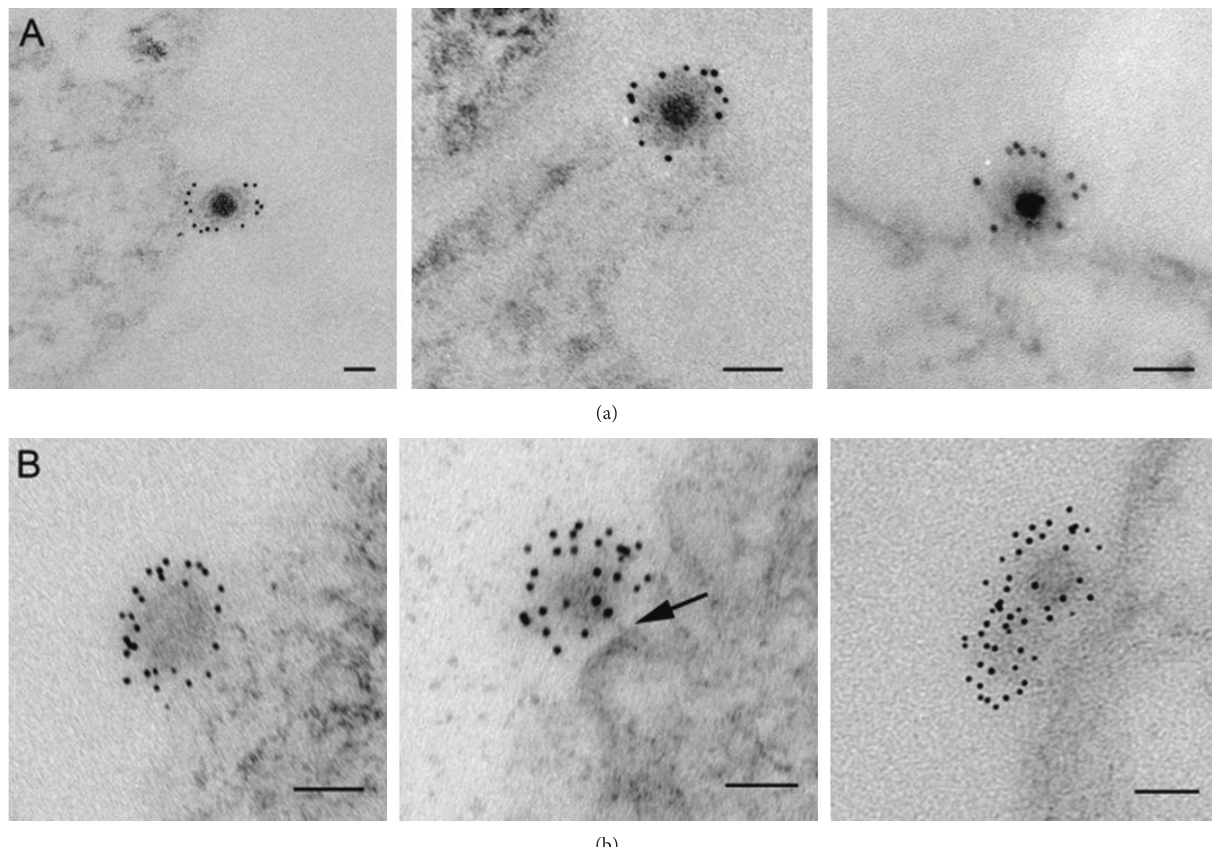
Figure 13: Thin-section electron microscopy of Sindbis virus-cell complexes at pH 7.2. A panel of images obtained by TEM illustrates two representative populations of particles at different incubation temperatures. High-magnification images show examples of electron-dense full particles at the cell surface at 4 ∘ C (row (a)) and empty particles with loss of RNA electron density predominantly at 37 ∘ C (row (b)). In row (b), middle panel, there is indication of a stalk connecting the virus and the cell (arrow). Bars, 50 nm. From Vancini et al. 2013 [133].